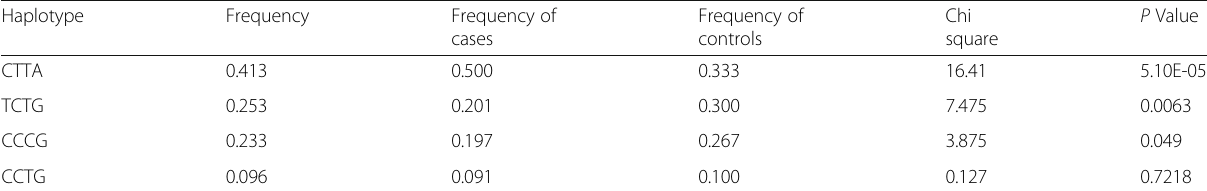
Table 4 Association of haplotypes with lung adenocarcinoma Haplotype